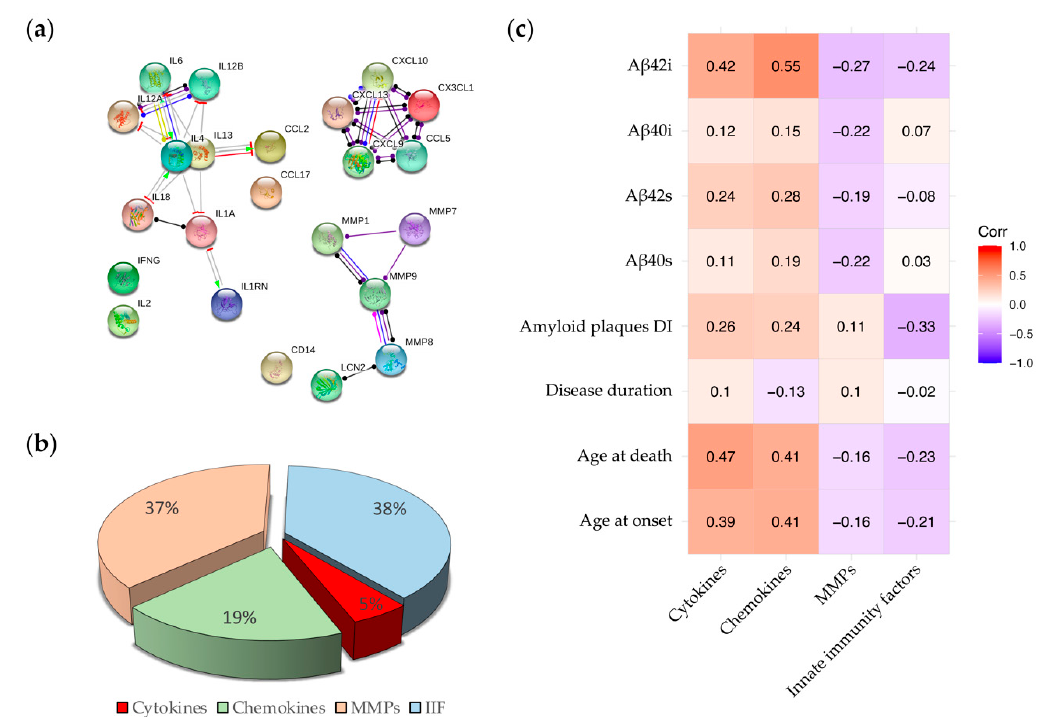
Figure 5. Families of neuroinflammatory factors. ( a ) STRING network highlights the direct (physical) and indirect (functional) connection of elements belongs to each family. Known interactions: from curated databases (light blue), experimentally determined (purple); predicted interactions: gene neighborhood (green), gene fusions (red), gene co-occurrence (blue); other interactions: text mining (yellow), co-expression (black), protein homology (grey). ( b ) Pie graph indicates the relative distribution of cytokines (red), chemokines (green), MMPs (pink) and IIFs (blue) within the AD group. ( c ) The heat map shows correlations between the four neuroinflammatory classes and clinical, neuropathological and biological data. A β 42 levels in the insoluble fraction of brain homogenates (A β 42i); A β 40 levels in the insoluble fraction of brain homogenates (A β 40i); A β 42 levels in the soluble fraction of brain homogenates (A β 42s); A β 40 levels in the soluble fraction of brain homogenates (A β 40s).